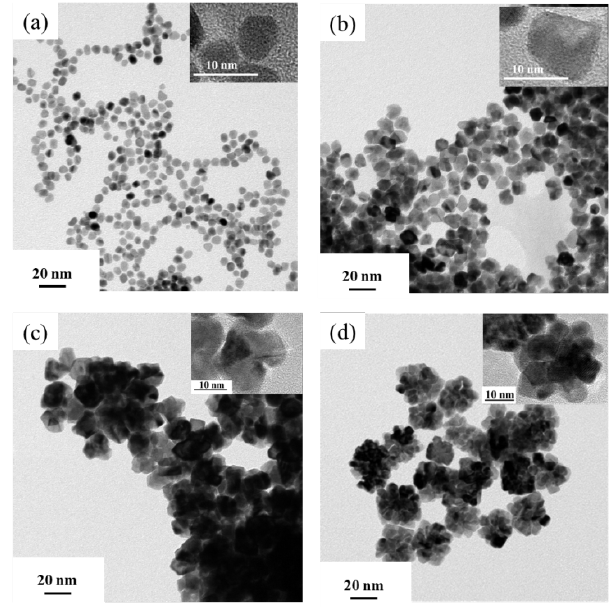
Figure 2. TEM images of Pt nanoparticles obtained by adding HCl and polyvinylpyrrolidone (PVP) with different concentrations: ( a ) Pt-0 HCl (without HCl), ( b ) Pt-3.7 HCl (3.7 wt% HCl), ( c ) Pt-9.25 HCl (9.25 wt% HCl), and ( d ) Pt-2 PVP (0.075 M PVP), Inset: TEM images of single Pt nanoparticle.